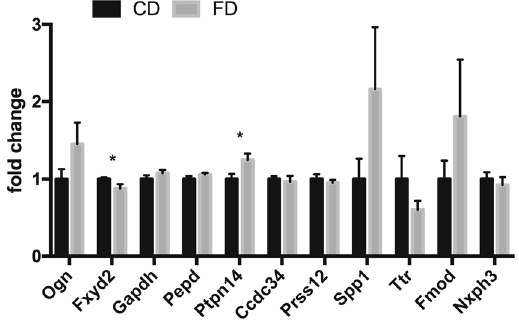
Figure 6. Expression changes of candidate genes in hippocampi of CD and FD F1 mice evaluated by qPCR. The graph shows normalized fold change values relative to control samples. Data are presented as mean ± S.E.M.; asterisks denote significant differences ( * p < 0.05; n = 6 per